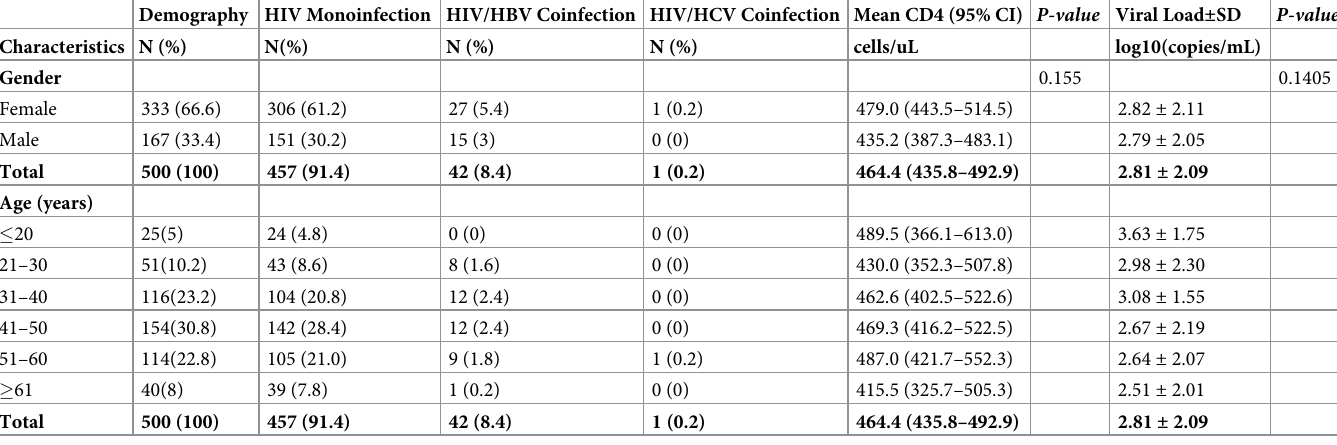
Table 1. Patient demography and clinical baseline